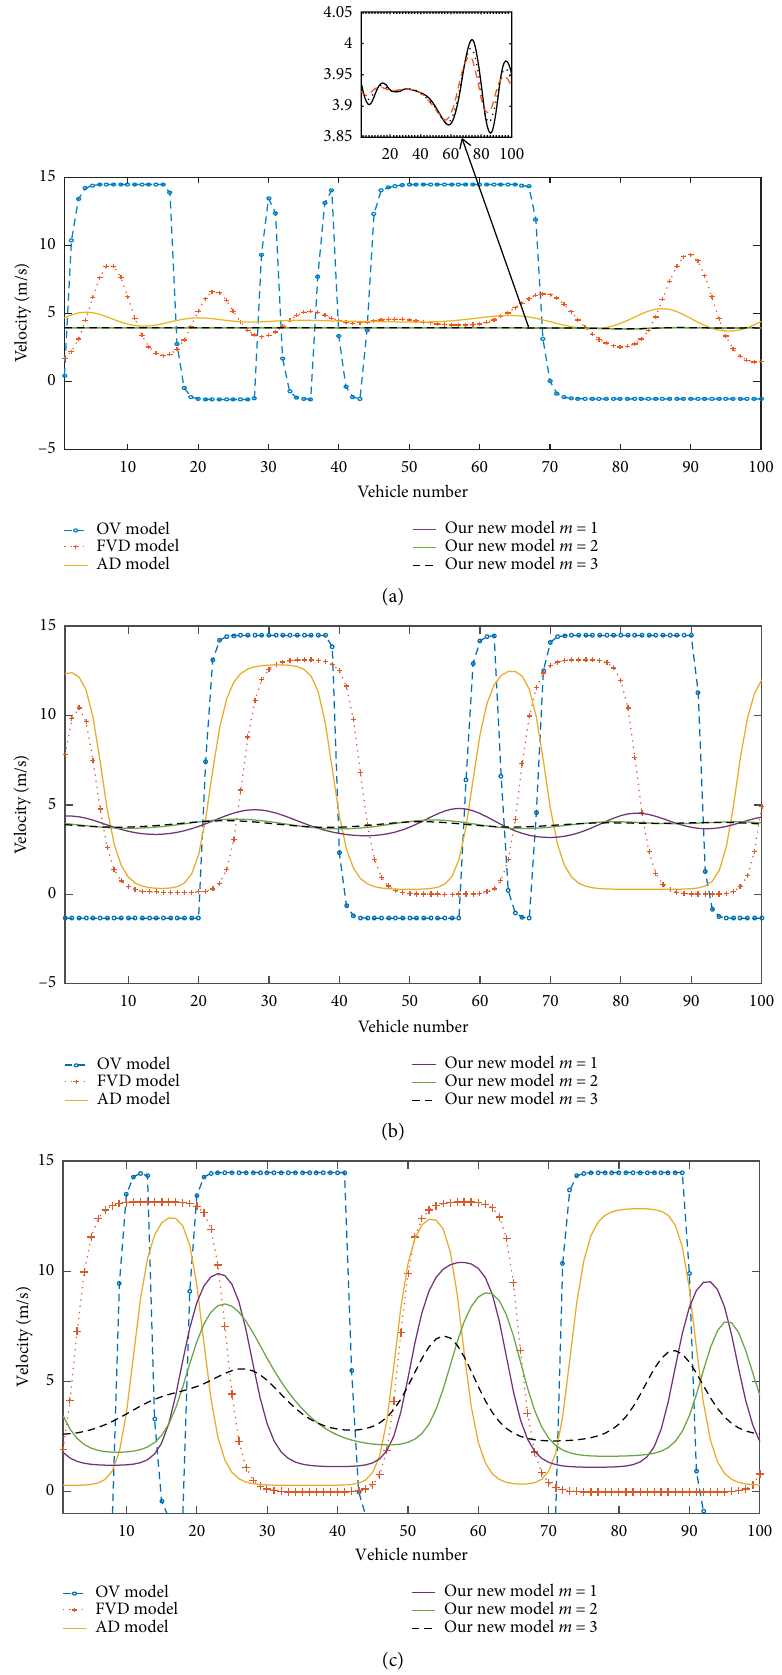
Figure 6: Snapshots of velocities of all vehicles according to different car-following models in t = 1000 s, and (c) t = 2000